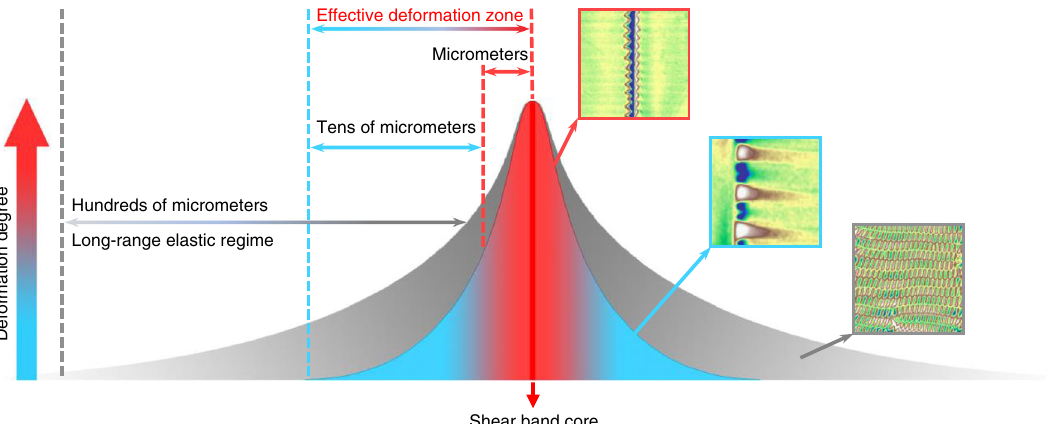
Fig. 6 Schematic of the shear-band affected zone. The gray region represents the hundreds of micrometers long-range elastic regime. The colored region stands for the effective deformation zone of shear banding: the bright red line stands for the core of a shear band with nanoscale; the red region represents the severely deformed zone with several micrometers in wide; the light blue region represents the extended strain gradient fi eld with tens of micrometers long. The three 30 × 30 µ m 2 MFM phase images stand for the typical magnetic domain patterns (wave-like domain pattern, extending domain pattern, zipper-like domain pattern) in the corresponding